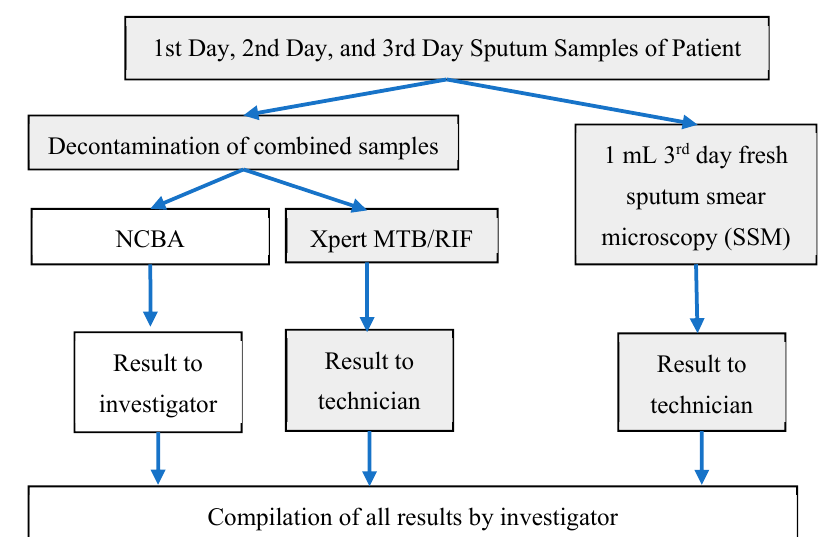
Figure 1. Schematic diagram of sample handling and processing. Activities conducted by the technician are identified as grey boxes while activities conducted by the investigator are white boxes. Sputum sample obtained on the third day from the same patient was tested for AFB by SSM and the remainder was combined with the earlier two samples for testing by NCBA and Xpert MTB/RIF.